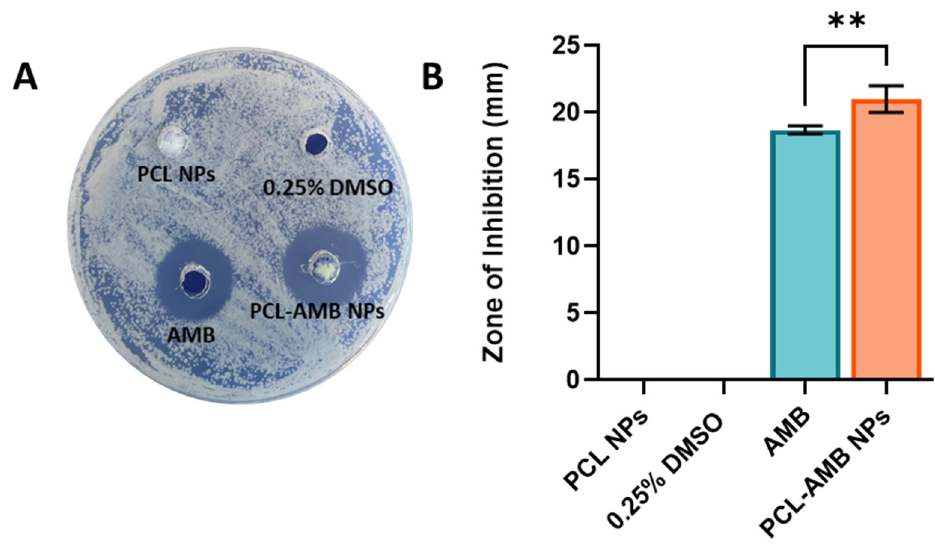
Figure 5. Zone of inhibition for PCL NPs, 0.25% DMSO in MQ water, AMB in 0.25% DMSO, and PCL-AMB NPs in MQ water using C. albicans ATCC 10231 ( A ). Zone of inhibition for PCL NPs, 0.25% DMSO in MQ water, free AMB, and PCL-AMB NPs calculated in millimetres ( B ). Bar graphs represent as mean ± SD, n = 3 and ** p < 0.01.